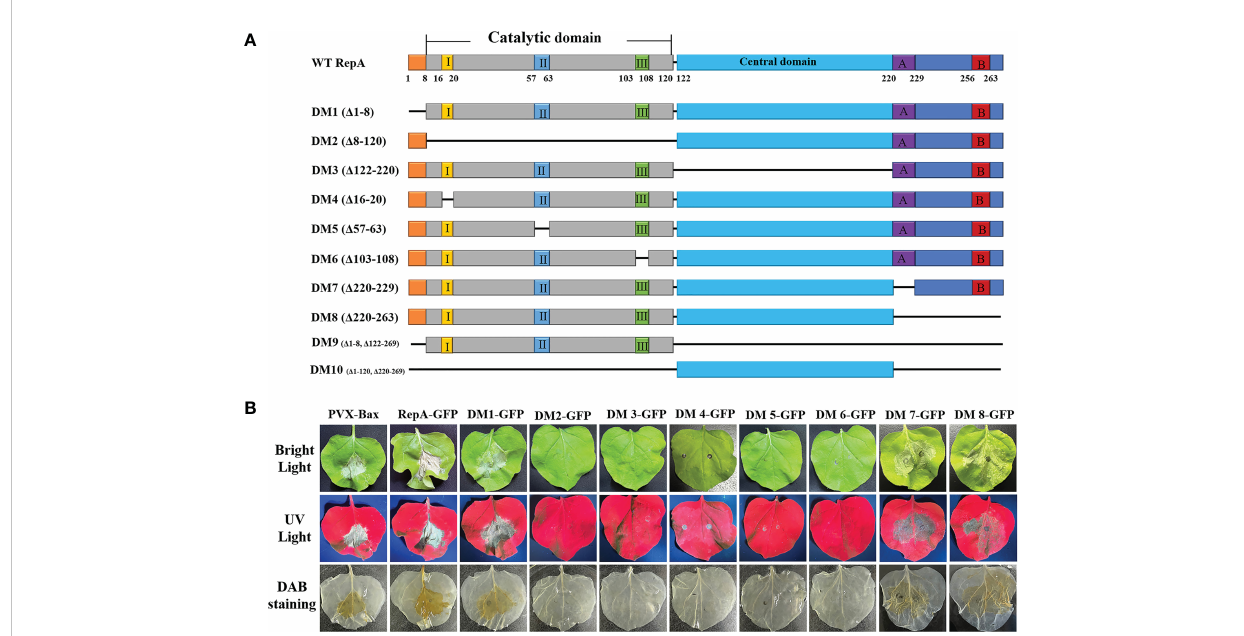
FIGURE 2 Mapping the key domains in CCDaV-RepA associated with HR-like cell death. (A) Schematic representation of RepA and its derivatives used in this study. I, II, and III indicate the conserved motifs in the catalytic domain contains. A and B indicate the Walker A and B motifs, respectively. (B) RepA-GFP and RepA DM1-8 -GFP were transiently expressed in N. benthamiana and imaged under bright light (top panels), ultraviolet light (middle panels), and after staining with 3,3 ′ -diaminobenzidine (DAB) (bottom panels) at 5 days post-in fi ltration (dpi). All sample measurements were repeated four